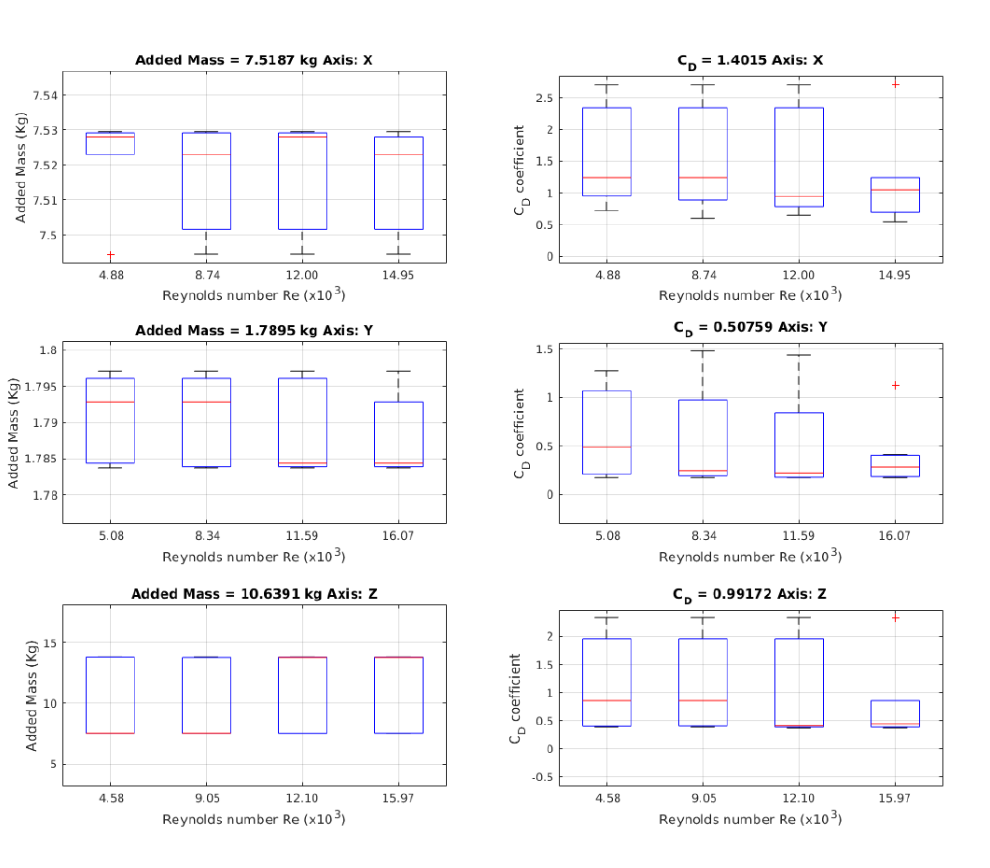
Figure 8. Values for the added mass obtained using a free decay experiment by least squares as in the Chin method. On the left, the results for the values for added mass are shown. On the right, the values of drag coefficients are